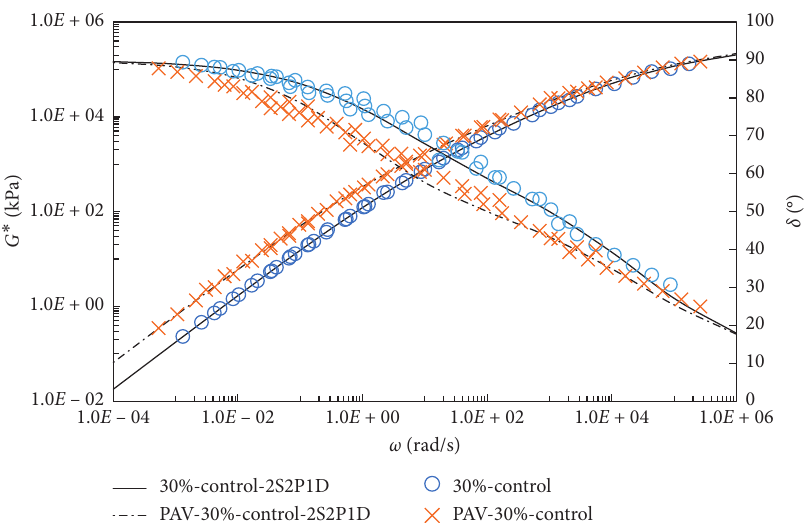
Figure 5: Complex shear modulus and phase angles master curves for control binder containing 30% RAP binder before and after PAV aging.